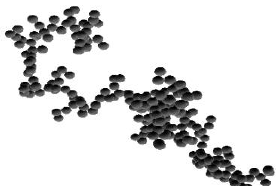
Fig. 5 Model morphology of soot fractal aggregate used in STMM simulations.